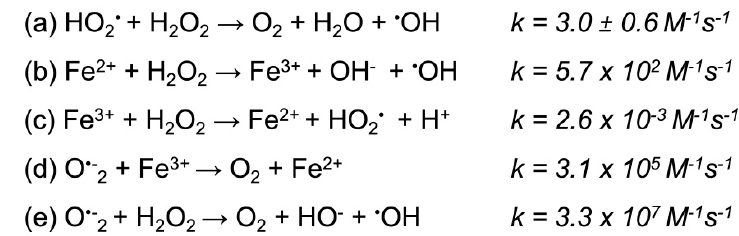
Figure 5. Haber–Weiss reaction scheme. The Haber–Weiss reaction generates hydroxyl radicals from hydrogen peroxide, and superoxide catalyzed by iron ions; k , reaction rate coe ffi cient. ( a ) The reaction is too slow and cannot a ff ect cellular processes. ( b ) A catalyst (iron) was used, which was already known in the Fenton reaction. ( c ) Iron ions formed in the Fenton reaction were reduced to iron ions by hydrogen peroxide. ( d ) In order for the reaction to proceed at a faster rate, a reducing agent was added: superoxide anion radical. ( e ) As a result of the b and d reactions and iron ions, the Haber–Weiss reaction was obtained, which proceeds at a high rate according to [78–80].